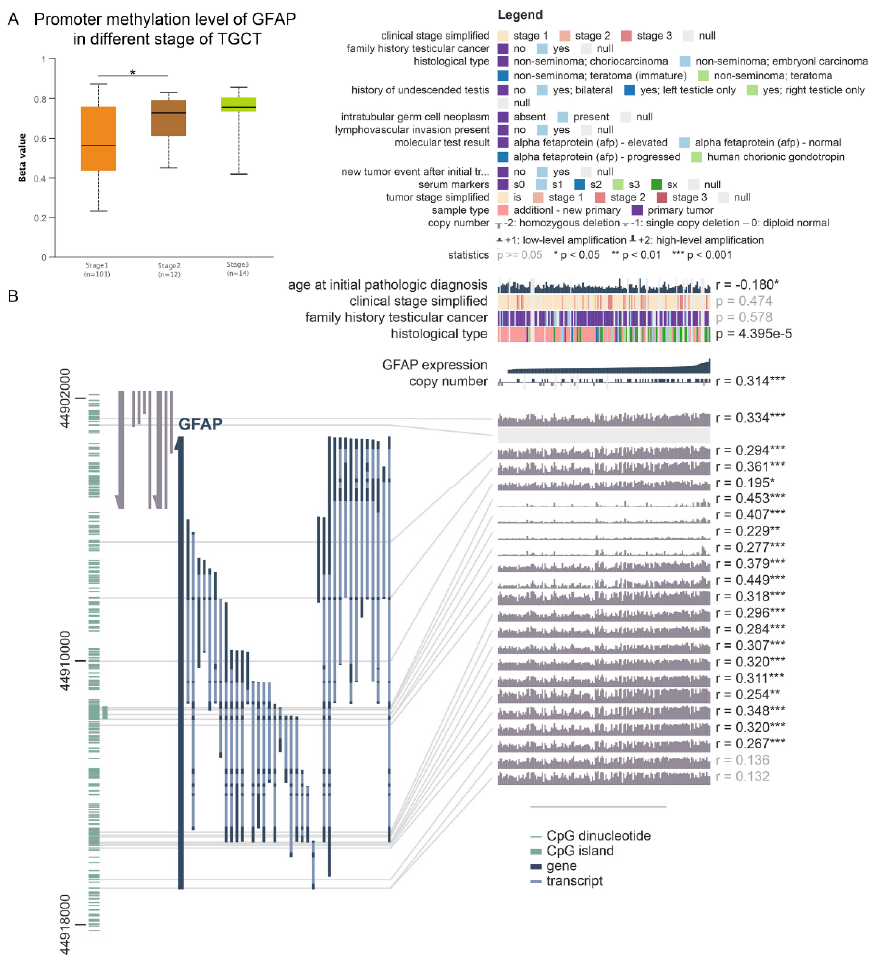
Figure 7. Methylation analysis of GFAP ( A ) Methylation was assessed using DiseaseMeth version 2.0. ( B ) The methylation site of GFAP DNA sequence association with gene expression was visualised using MEXPRESS. *, p < 0.05; **, p < 0.01; ***, p < 0.001 .